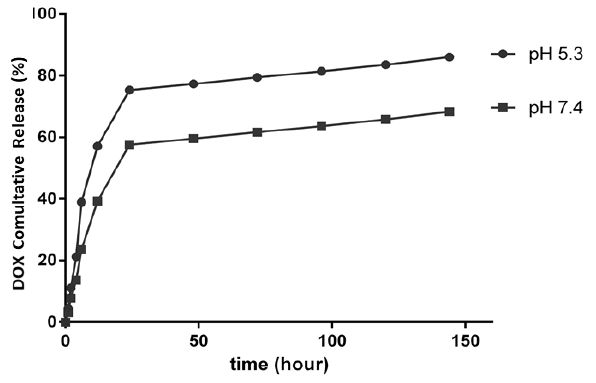
Figure 1: The cumulative release of DOX at various pH values (5.3 and 7.4) at 37°C.